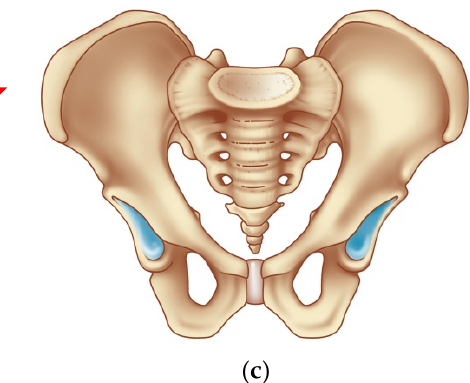
Figure 2. ( a ) Titanium pin with the zone for marker attachment; ( b ) View of patient with implanted pin; ( c ) Bone reference point—anterior superior iliac spine on the right. Based on the CT data of the abdomen and small pelvis, a virtual model of the small pelvic organs was built for additional visualization of the location and invasion of the tumor into the surrounding tissues and organs (Figure 3).